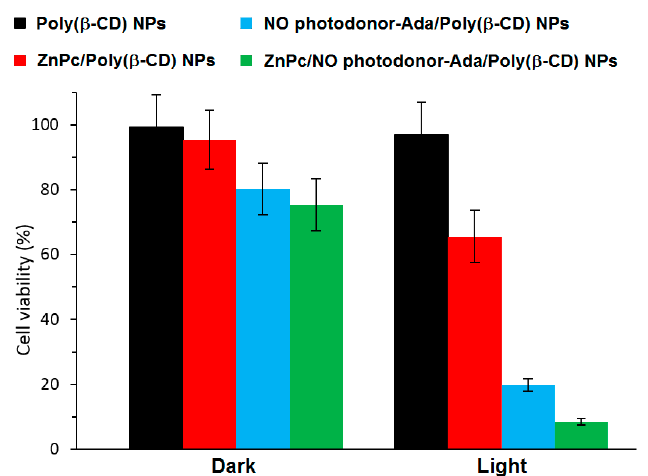
Figure 46. Dark and photoinduced mortality of A431 cells incubated with aqueous dispersion of Poly( β -CD), ZnPc/Poly( β -CD), NO photodonor-Ada/Poly( β -CD), and ZnPc/NO photodonor-Ada/Poly( β -CD) NPs. The samples were simultaneously irradiated with 405 nm (10 J/cm 2 ) and 633 nm (10 J/cm 2 ) LED sources. [Poly( β -CD)] = 11 µ M (7.75 mM in β -CD), [ZnPc] = 15 µ M, [NO photodonor-Ada] = 40 µ M. Adapted from Kandoth; Kirejev; Monti; Gref; Ericson; Sortino [178].